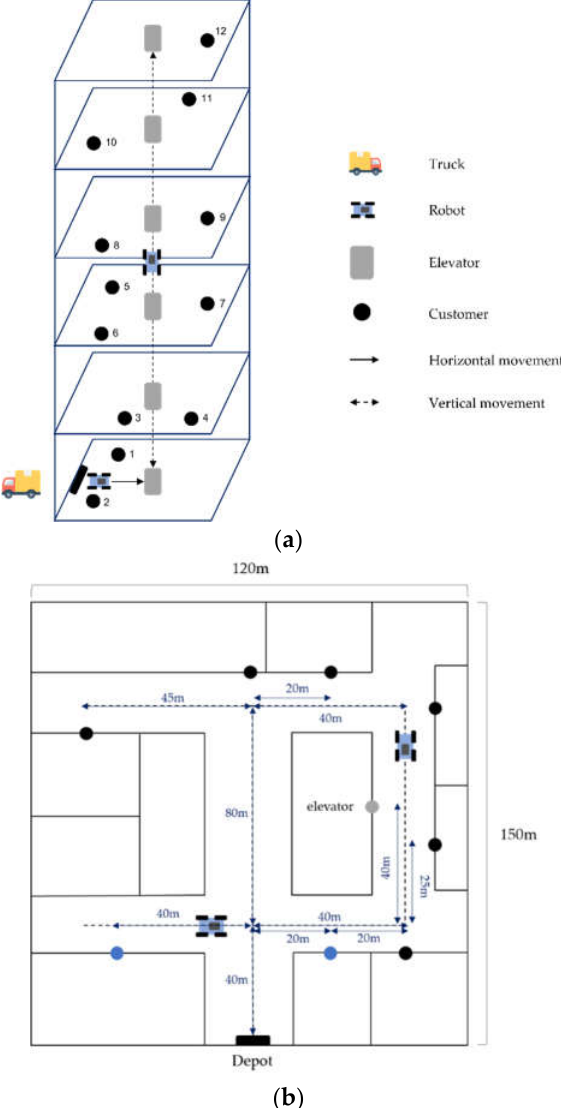
Figure 7. Illustrative example building: ( a ) indoor network; ( b ) indoor layout of the first floor.